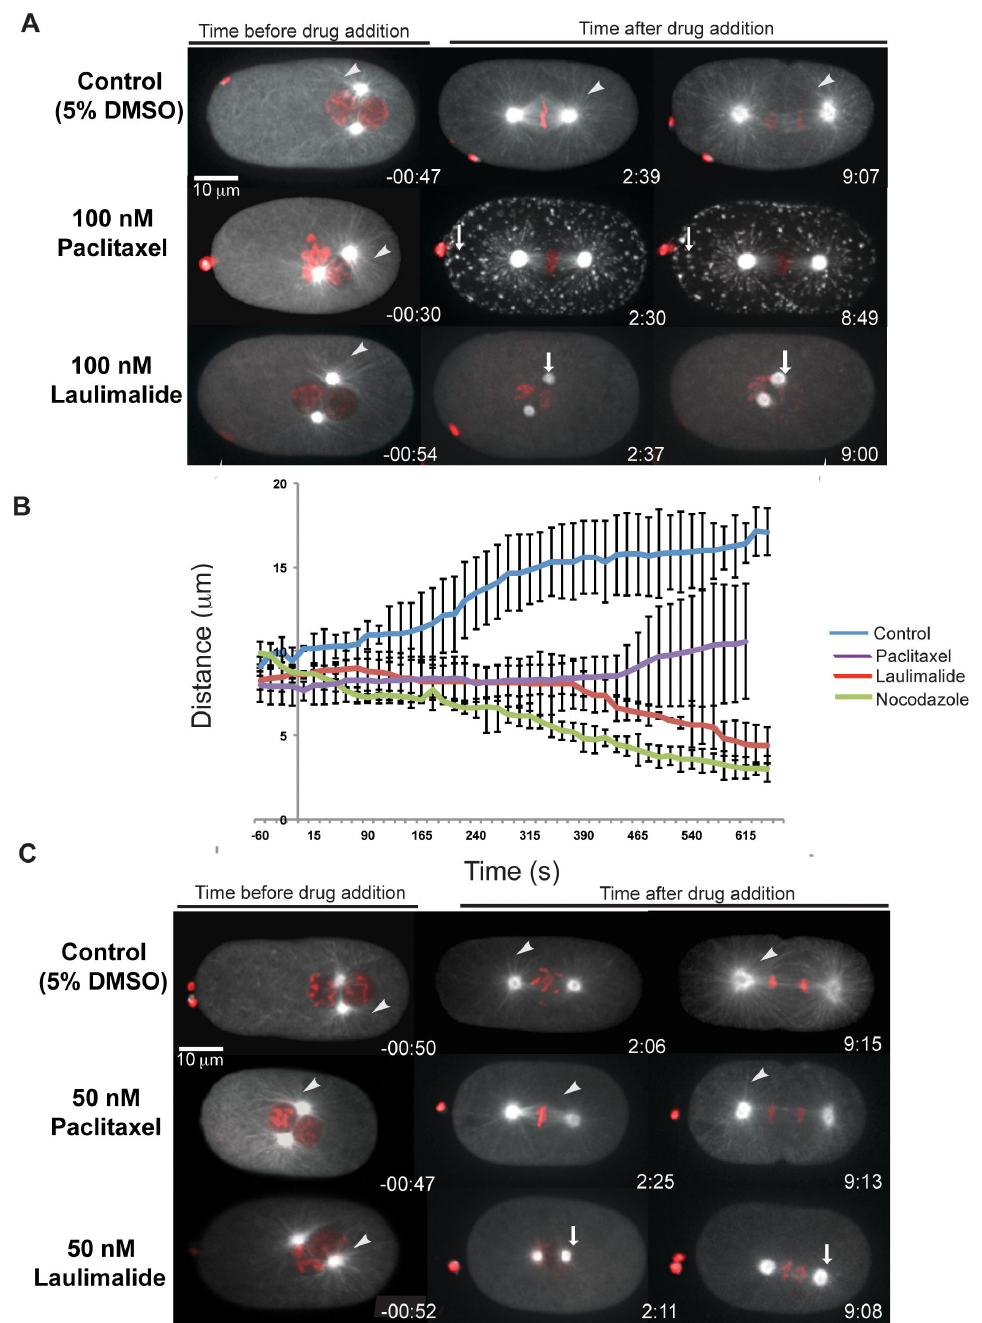
Figure 2. Laulimalide destabilizes microtubules at low concentration. Confocal images of embryos expressing GFP-tubulin and mCherry-histone were treated with 5% DMSO (control), paclitaxel, or laulimalide, as shown. The posterior of the embryos is to the right. The white arrowhead points to the microtubule fibres, which were observed in all embryos before drug addition. A) Paclitaxel-treated embryos exhibit tubulin aggregates (white arrows). In 100 nM laulimalide-treated embryos, fluorescence was visible only at the centrosomes (white arrows) after drug addition B) A graph shows the distance between centrosomes in control embryos and embryos treated with laulimalide (100 nM), paclitaxel (100 nM), and nocodazole (100 nM). The data is an average of 3 embryos for each trial. Error bars indicate standard deviation. C) Control embryos and embryos treated with 50 nM paclitaxel divide normally. Laulimalide-treated embryos (50 nM) do not complete cell division and embryos displayed an increase in fluorescence intensity at the centrosomes and fewer microtubule fibres after drug addition (white arrows). doi: 10.1371/journal.pone.0071889.g002 PLOS ONE |